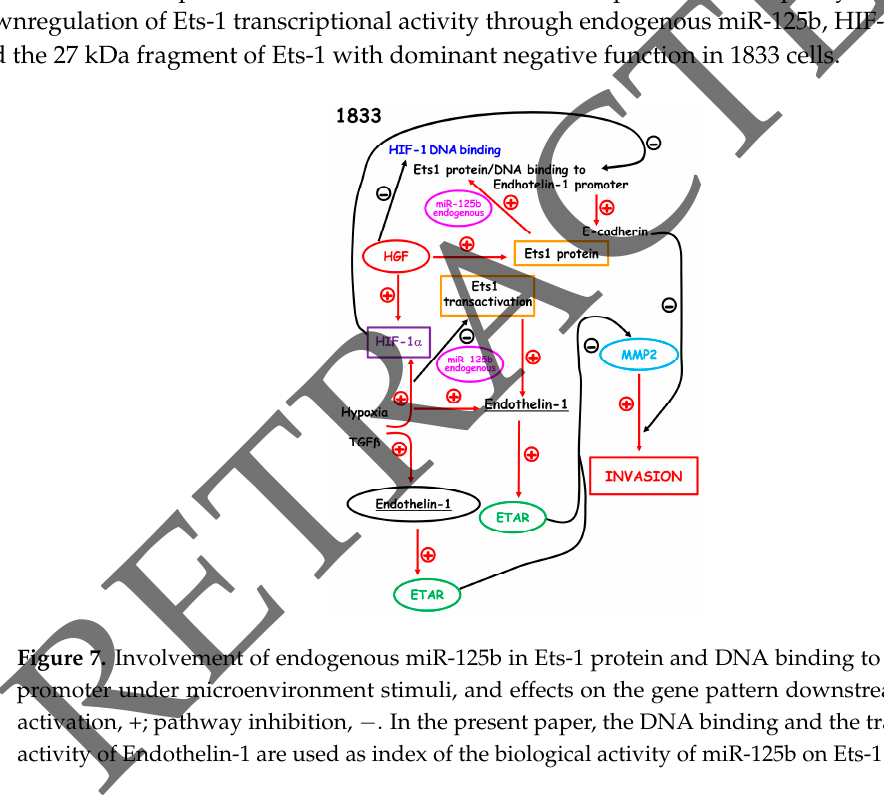
Figure 7. Involvement of endogenous miR-125b in Ets-1 protein and DNA binding to Endothelin-1 promoter under microenvironment stimuli, and effects on the gene pattern downstream. Pathway activation, +; pathway inhibition, − . In the present paper, the DNA binding and the transactivating activity of Endothelin-1 are used as index of the biological activity of miR-125b on Ets-1 function.